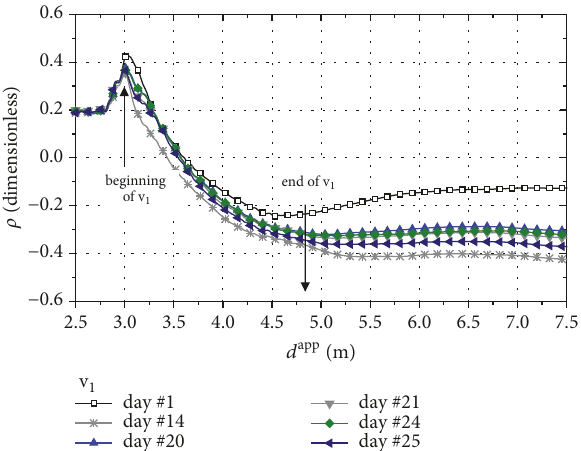
Figure 7: Experiment #2: reflectograms acquired from the vertical two-rod probe, v 1 .